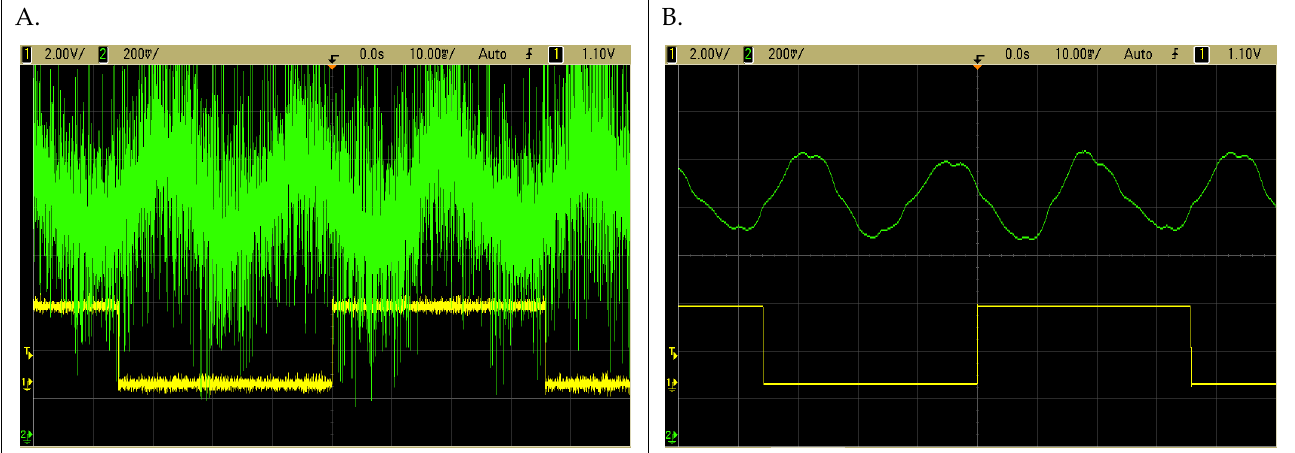
Figure 5. Oscillograms of winding current signal from LEM sensors obtained directly ( A ) and with 64 samples averaging ( B ).